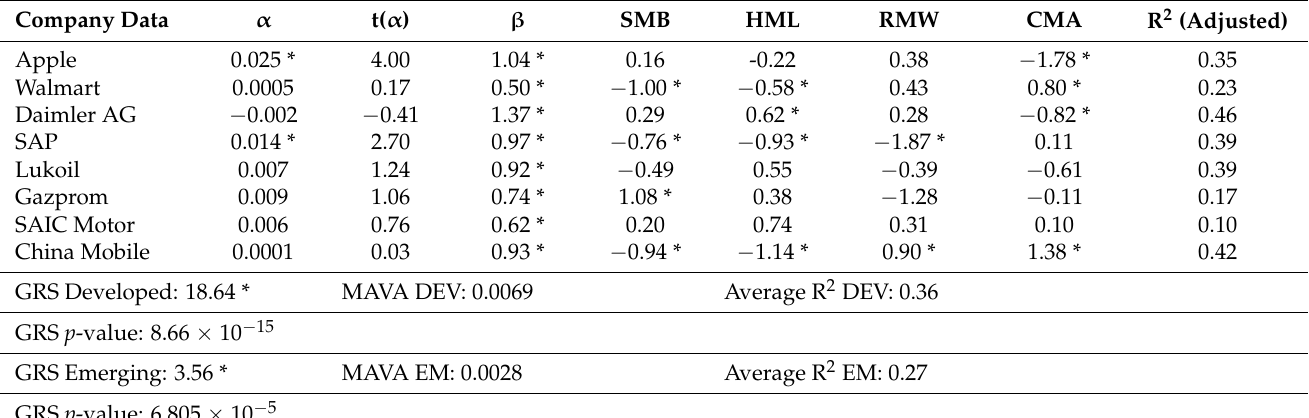
Table 5. Fama French five-factor regressions for company stock data—developed and emerging; * p < 0.05.